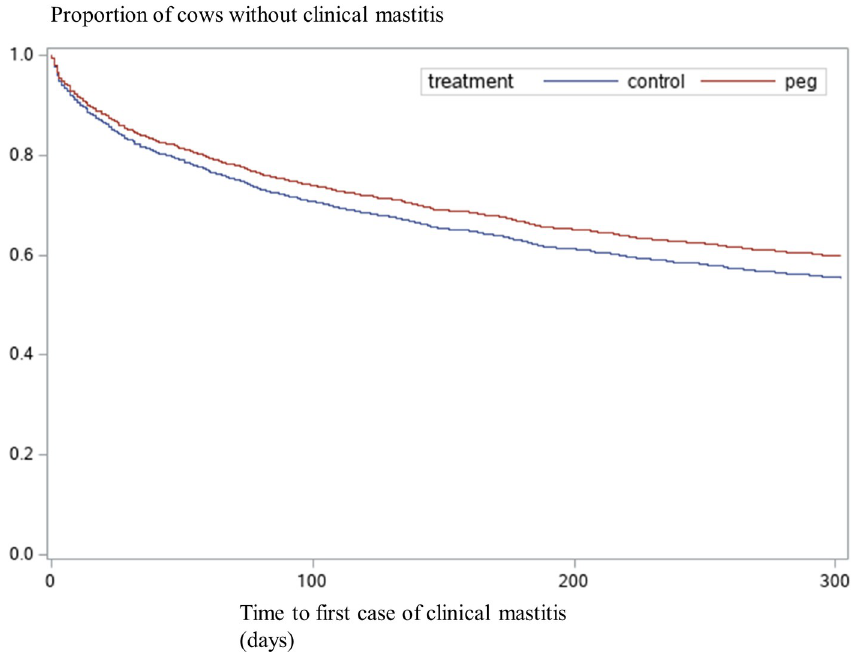
Fig 3. Survival curves of time to first case of clinical mastitis. Control cows = 1,114, PEG cows = 1,039. Treatment P –value = 0.008 (Table 3).